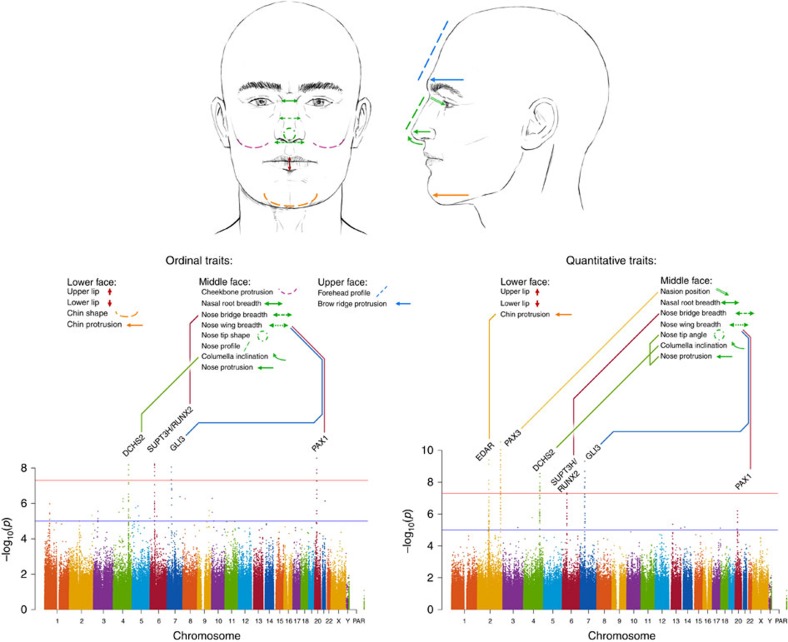
Overview of GWAS for facial features in the CANDELA sample.We first carried out a GWAS using data for 14 ordinal facial features from the lower, middle and upper face in 5,958 individuals. For follow-up, we obtained quantitative proxies for 9 of the 14 ordinal traits initially examined (and also obtained a measure of nasion position) in a subset of 2,955 individuals, and performed another GWAS. For convenience, we summarize results across traits on a single ‘composite' Manhattan plot shown at the bottom of the figure (ordinal traits on the left and quantitative traits on the right). Each Manhattan plot displays all the SNPs with P values exceeding thresholds for genome-wide suggestive (10−5, blue line) or genome-wide significance (5 × 10−8, red line) for any trait. To avoid cluttering the figure, P values not reaching the suggestive threshold (that is, whose significance can be disregarded) are shown only for one trait (upper lip thickness). The names of the candidate genes closest to each association peak are provided (Table 1). These genes are connected with the list of associated facial features via lines of different colour. The location of these features is illustrated on the face drawings shown at the top of the figure. Face drawings were prepared by Emiliano Bellini. PAR, pseudo-autosomal region.